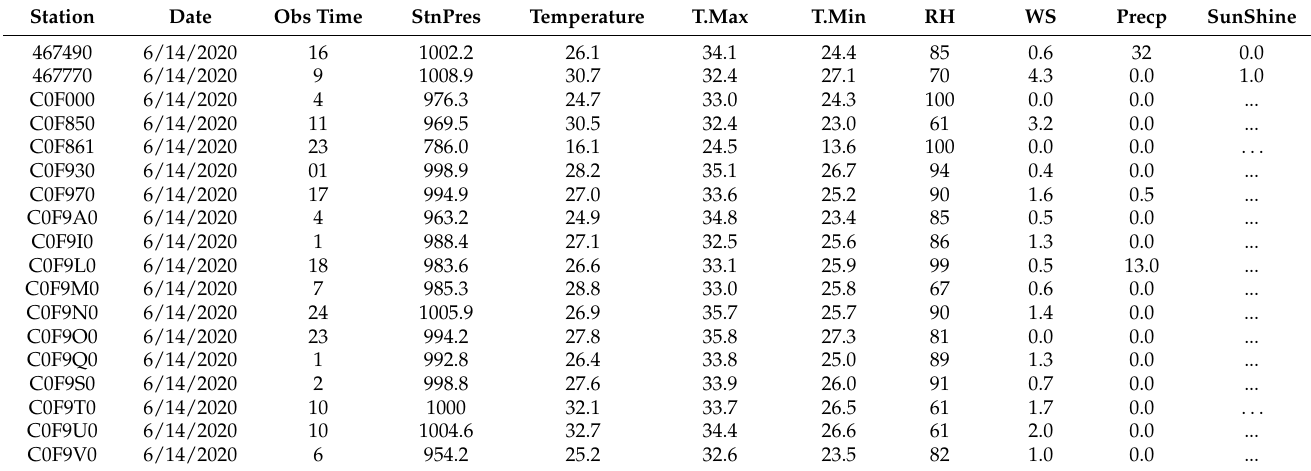
Table 1. Weather station